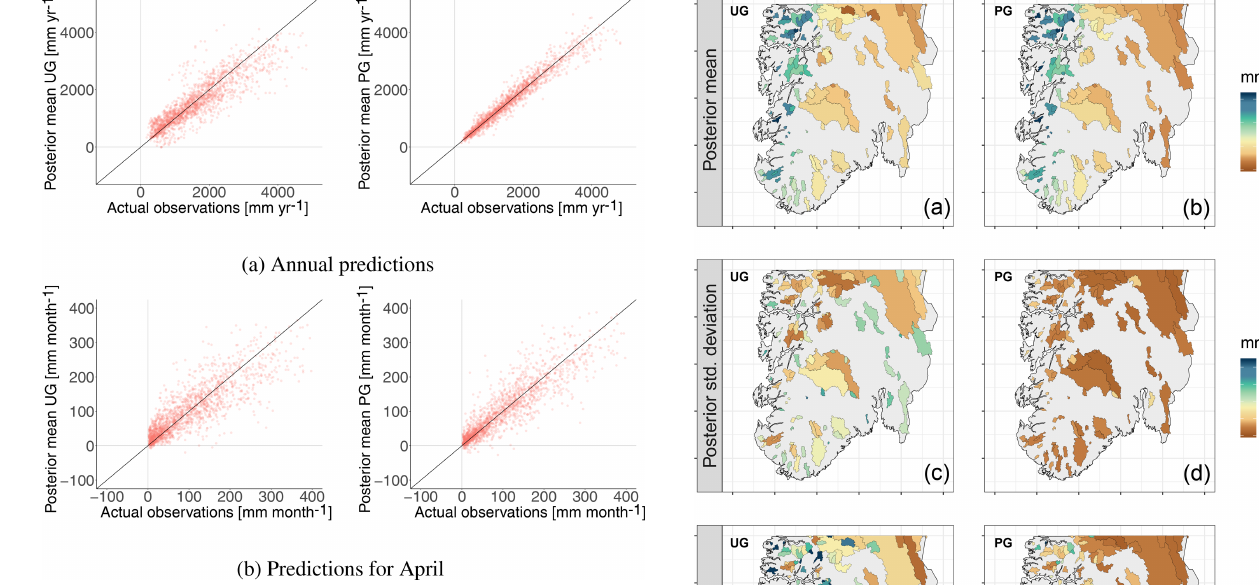
Figure 11. All observations for 1996–2005 compared to the cor- responding predictions for the ungauged case (UG, left) and the partially gauged case (PG, right) for annual predictions (a) and for April (b) . The predictions are performed by the areal model. The straight line represents a perfect correspondence between prediction and observation.